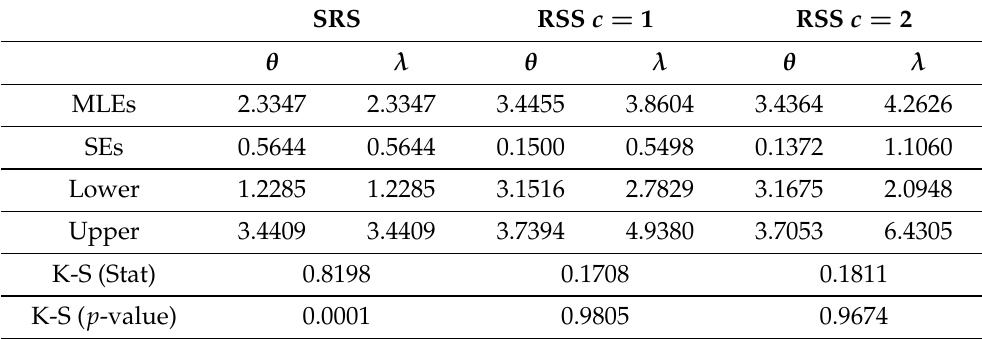
Table 14. MLEs of the parameters θ and λ of the GB( θ , λ ) distribution with lower and upper bounds of CI, SEs, Kolmogorov-Smirnov (K-S) (stat), and (K-S) p -value under the SRS and RSS schemes when n = 6.